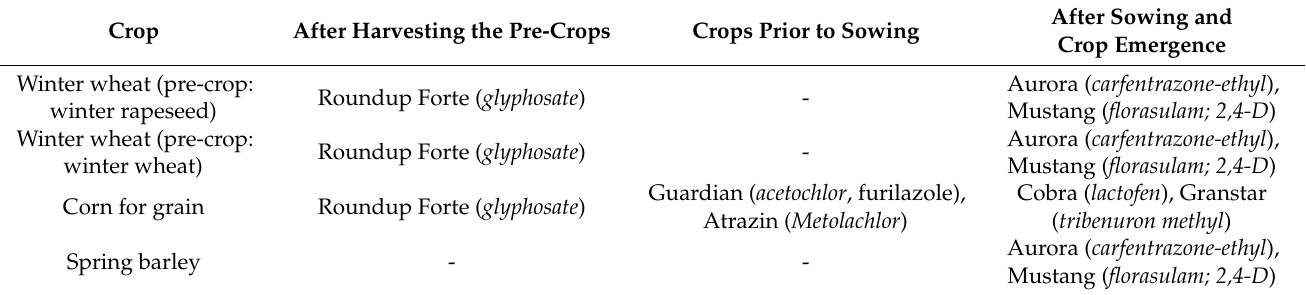
Table 1. Summary of herbicides applied in the crops monitored.